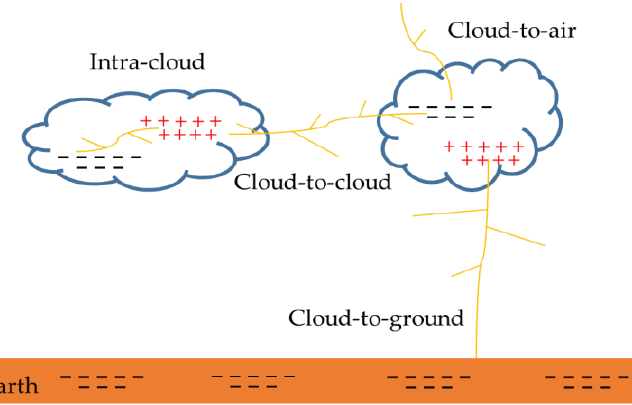
Figure 1. Di ff erent types of the lightning Figure 1. Different types of the lightning discharge.